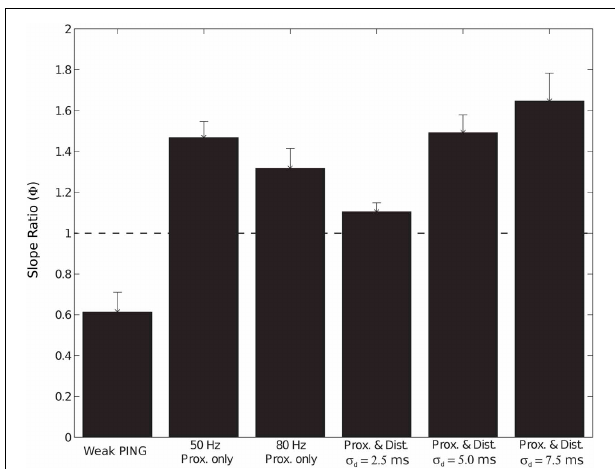
FIGURE 9 | Slope ratio ( (cid:2) ) significantly less than 1 for current dipole from weak PING but significantly greater than 1 for subthreshold (sub.) simulations. (cid:3) was calculated as mean of the ratio ( φ i ) of rising slope to falling slope for each cycle i of CD rhythm (see Methods and Figure 3 ). (cid:3) of 1 signifies that rising slope was equivalent to falling slope. Error bars represent standard error (s.e.) about the mean. (cid:3) values (relevant CD waveform in parentheses) found in: weak PING, 0 . 61 ± 0 . 09 ( Figure 3 ); sub. 50Hz proximal only, 1 . 47 ± 0 . 07 ( Figure 7A ); sub. 80Hz proximal only, 1 . 32 ± 0 . 09 ( Figure 7B ); sub. 50Hz proximal and distal, = 2 . 5ms, 1 . 1 ± 0 . 04 ( Figure 8A ); sub. 50Hz proximal and σ d distal, σ d = 5 . 0ms, 1 . 5 ± 0 . 04 ( Figure 8B ); sub. 50Hz proximal and distal, = 7 . 5ms, 1 . 65 ± 0 . 14 ( Figure 8C σ d